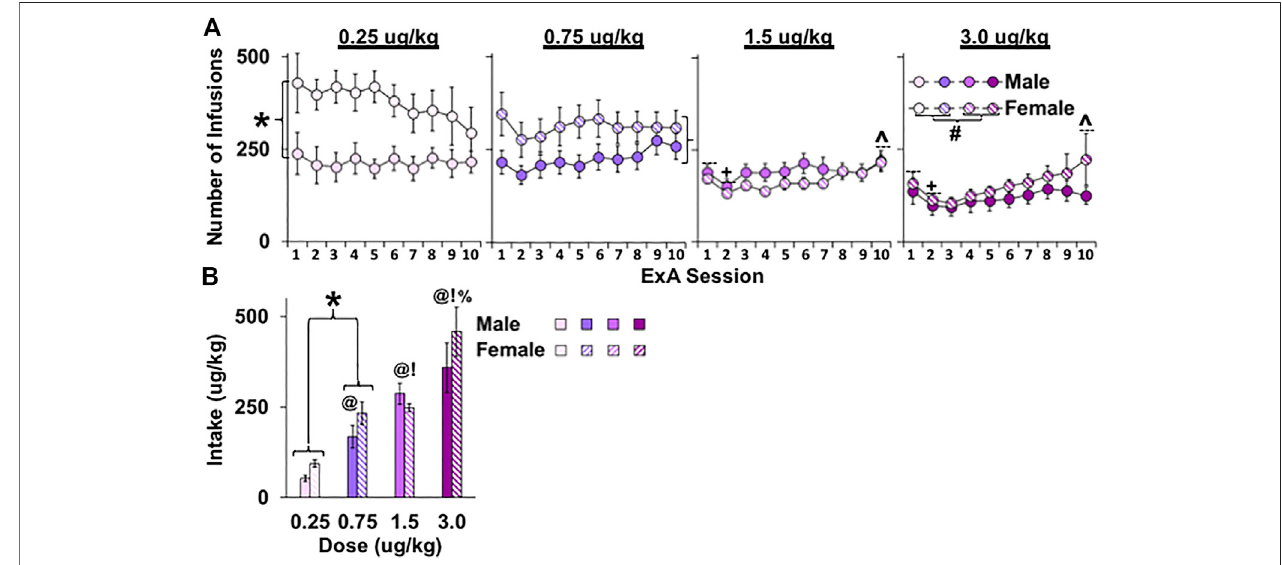
FIGURE1| Effectofsexanddoseonthenumberofinfusionsandfentanylintakeinfemaleandmaleratsunderextended-accessconditions.Mean(±SEM)number of infusions for each of the 10 extended-access sessions (A) and fentanyl intake averaged across the extended-access period ( μ g/kg); (B) for females and males in the 0.25 ( n = 8 males, n = 9 females), 0.75 ( n = 8 males, n = 9 females), 1.5 ( n = 8 males, n = 8 females), and 3.0 ( n = 8 males, n = 7 females) dose ( μ g/kg) conditions. (*) Signi fi cant sex difference within the two lower doses. (+) Signi fi cant decrease from session 1. ( ^ ) Signi fi cant increase from session 2. (#) Signi fi cant difference between the two lowest and two highest doses in females. Signi fi cant difference from (@) 0.25, (!) 0.75, and (%) 1.5 μ